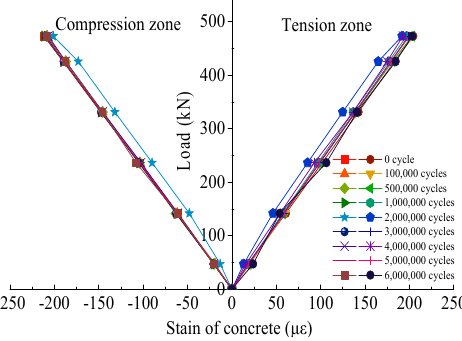
Figure 15. Load-concrete strain curves.